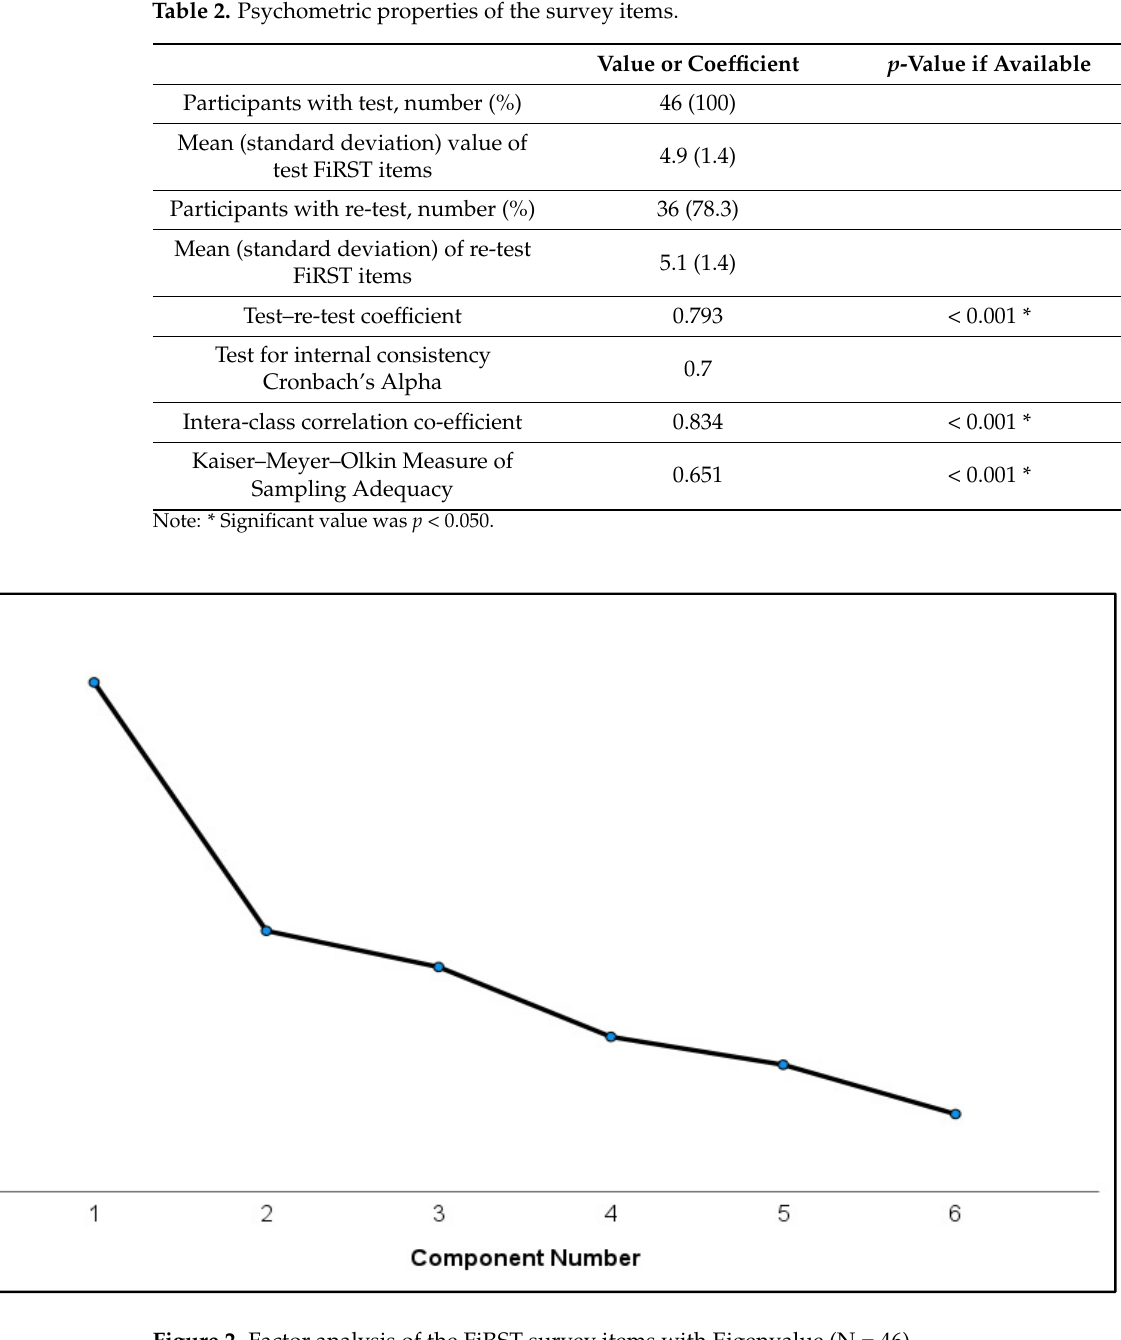
Figure 2. Factor analysis of the FiRST survey items with Eigenvalue (N = 46).